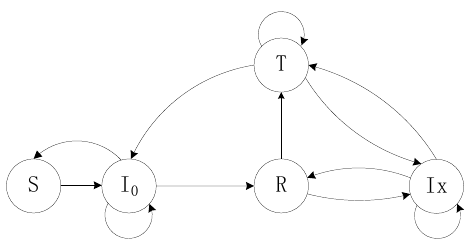
Figure 3. State transition diagram of a node in O-CDSA.